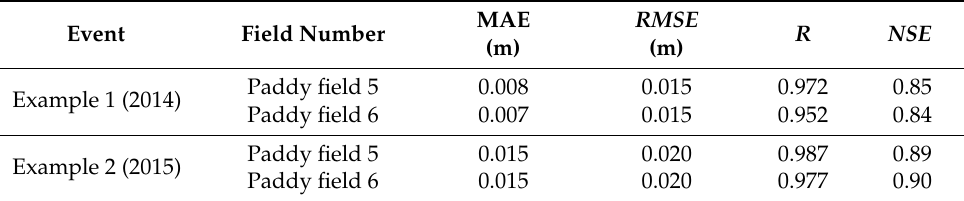
Figure 12. Graph of the measured and simulated flooded depth of specific fields. Table 9. Statistical table of evaluation indexes for model validation of field water depth.